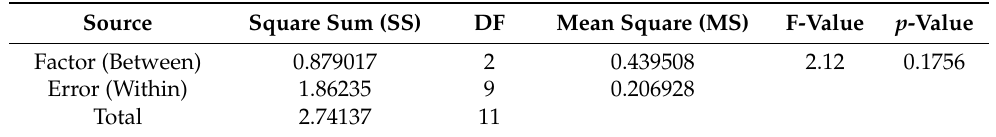
Table 13. Effect of P2 fiber type and temperature on f R,a by applying ANOVA